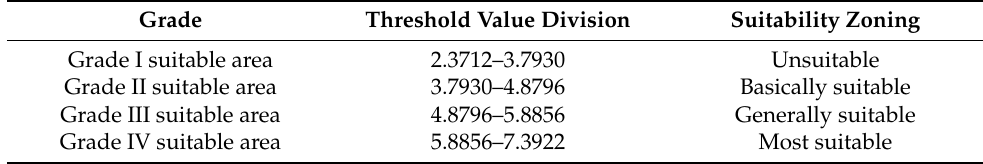
Figure 4. Suitability evaluation grid surface map. Table 3. Classification standard for suitability evaluation of rural residential